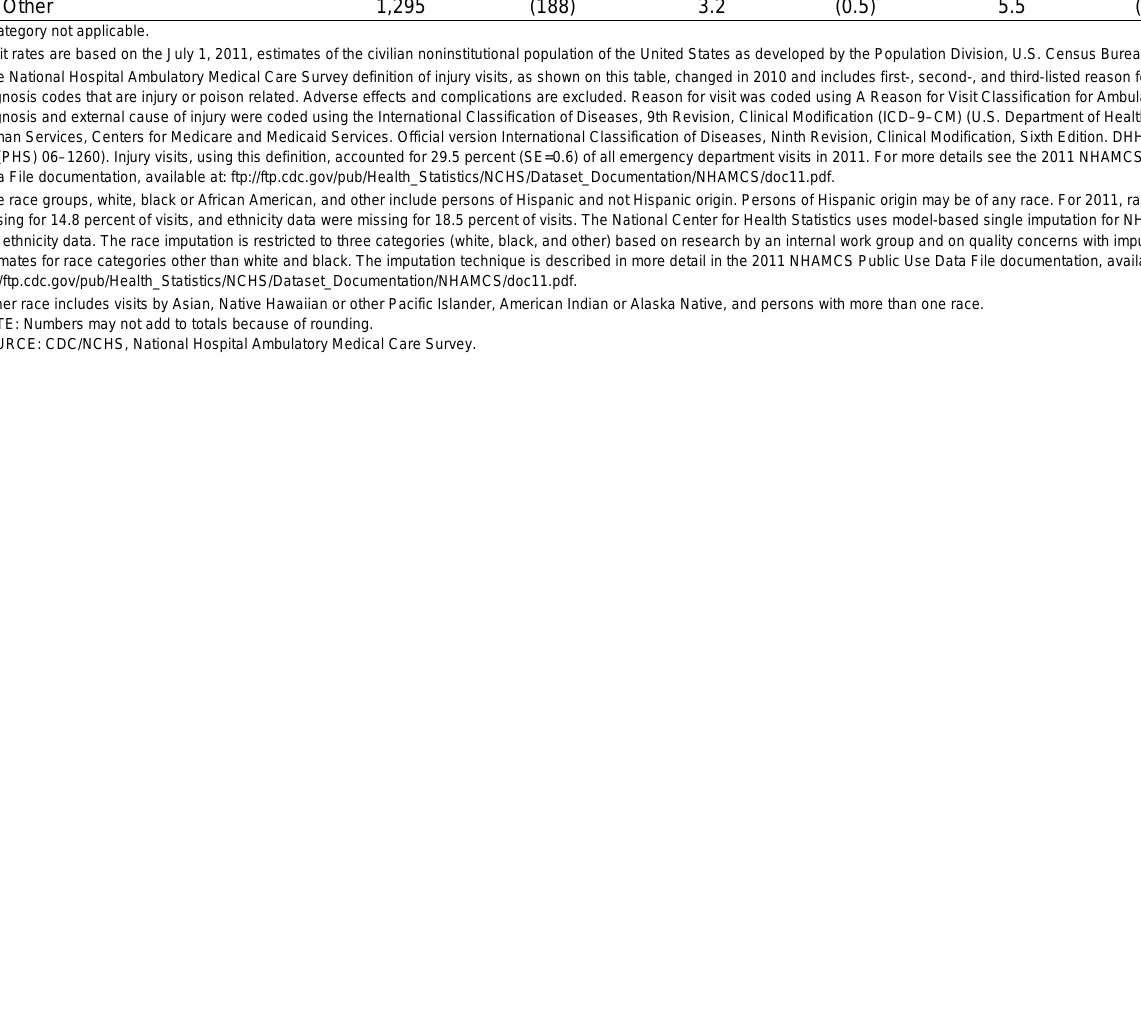
Number of visits per 100 persons per year Number of visits in thousands Percent distribution (standard error in thousands) (standard error of percent) (standard error of rate) 40,220 100.0 ...